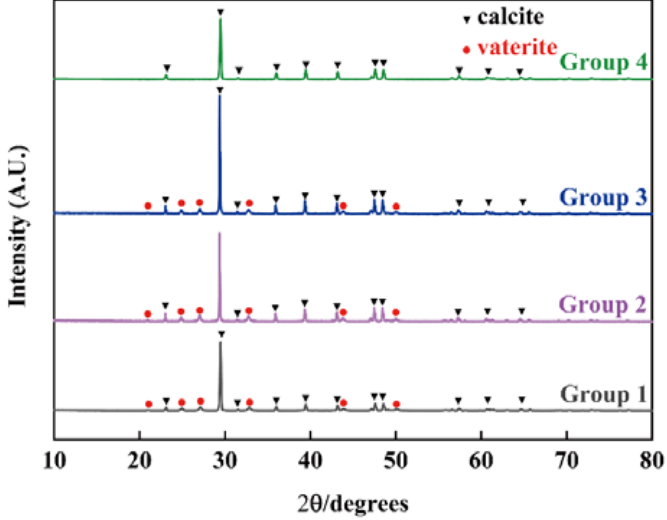
Figure 7. XRD patterns of CaCO 3 particles obtained after 4 h as a function of the concentration of nanobubbles in deionized water in groups 1 to 4.